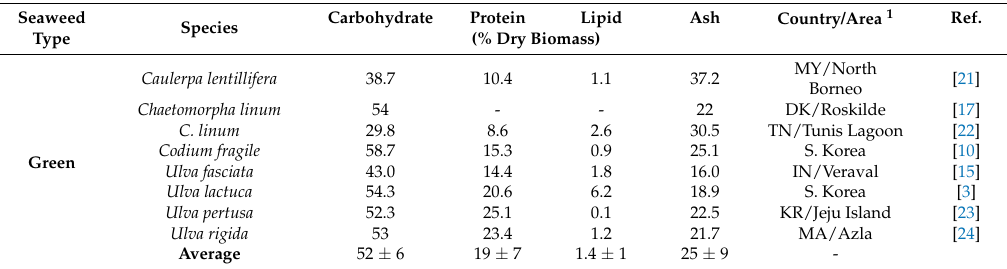
Table 1. Composition of selected seaweed